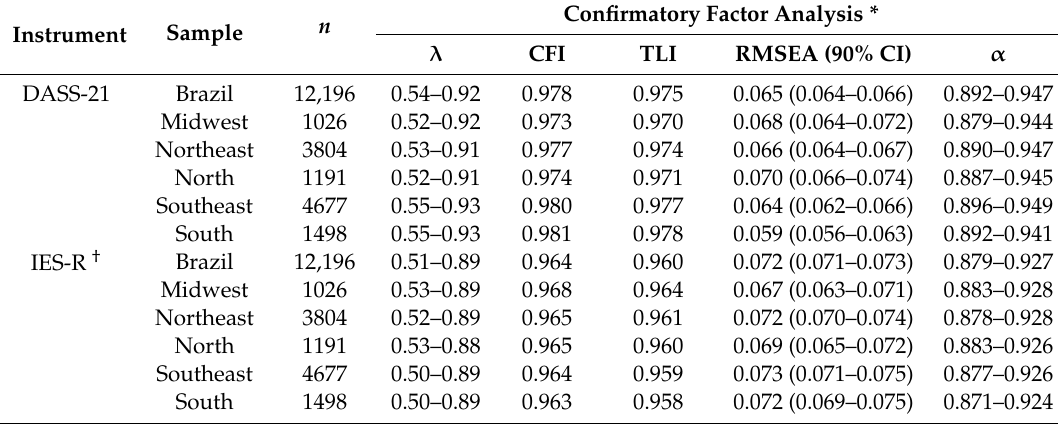
Table 1. Psychometric parameters for fit of the models to the samples of the instruments used (Depression, Anxiety and Stress Scale (DASS-21), and Impact of Event Scale-revised, (IES-R)).